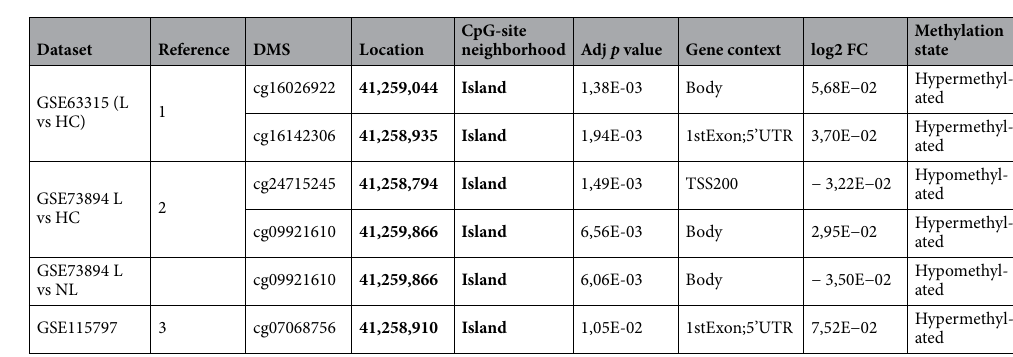
Table 2. Differentially methylated CpG sites in UCHL1 promotor in skin samples from psoriasis patients. Location: genomic coordinate_37 of the CpG site interrogated by the probe. CpG-site neighborhood: location of the gene-associated CpG-site(s) within the CpG-site neighborhood. Gene context: location of the gene- associated CpG-site(s) with respect to the gene context. Abbreviations: Adj p value: adjusted p value; CpG: Cytosine-Phosphate-Guanine sites; DMS: differentially methylated sites; HC: Healthy control skin; Log2FC: logarithm of the fold change of methylation values in psoriasis samples with respect to controls; L: psoriasis lesional skin; NL: psoriasis non-lesional skin; TSS200 Promoter regions 200 bp (base pairs) upstream of the transcription start site; 5’-UTR: 5’-untranslated region; vs: versus.